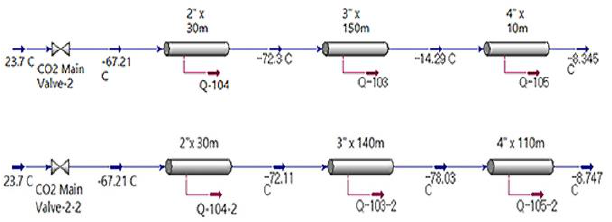
Figure 10. Example of temperature drop design according to the length of the carbon dioxide transfer line; at wind speed: 10 m/s ( above ), 5 m/s ( below ).